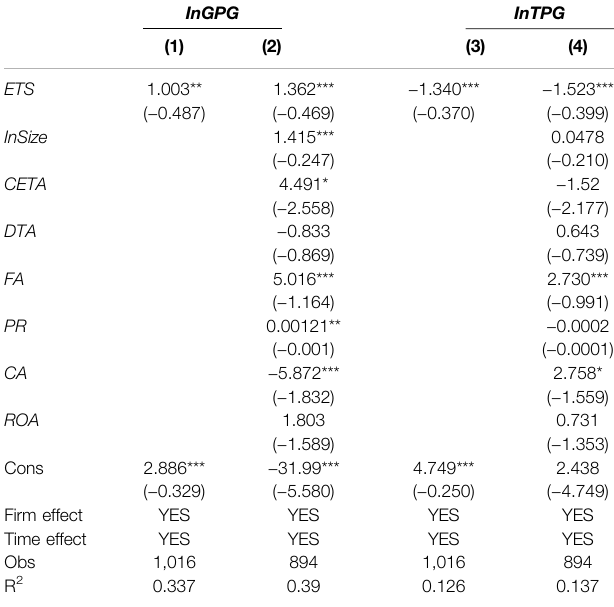
TABLE 4 | The regression results of clean and thermal power generation.